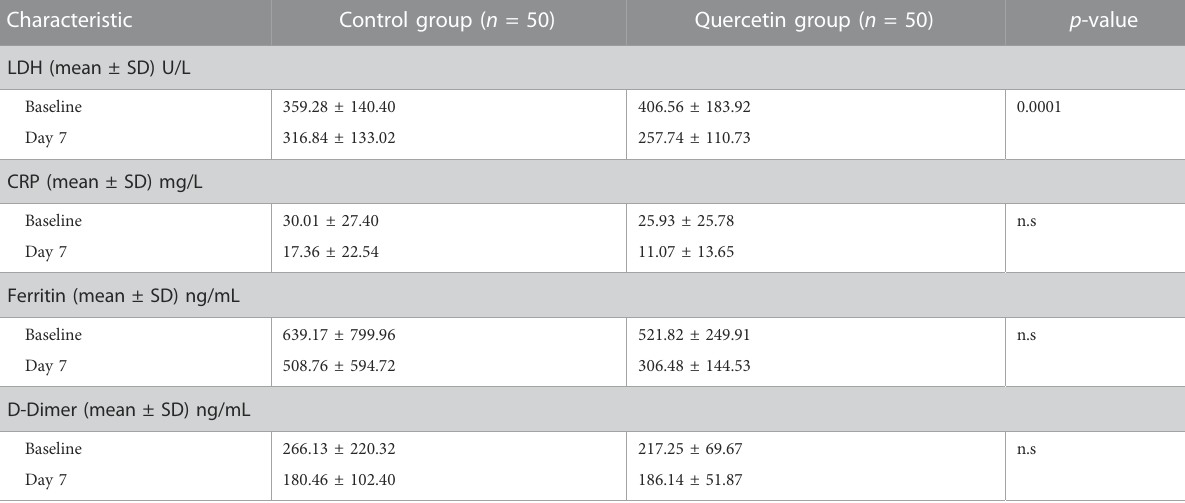
TABLE 2 Patient ’ s baseline and day 7 in fl ammatory biomarkers levels in the two treatment groups.